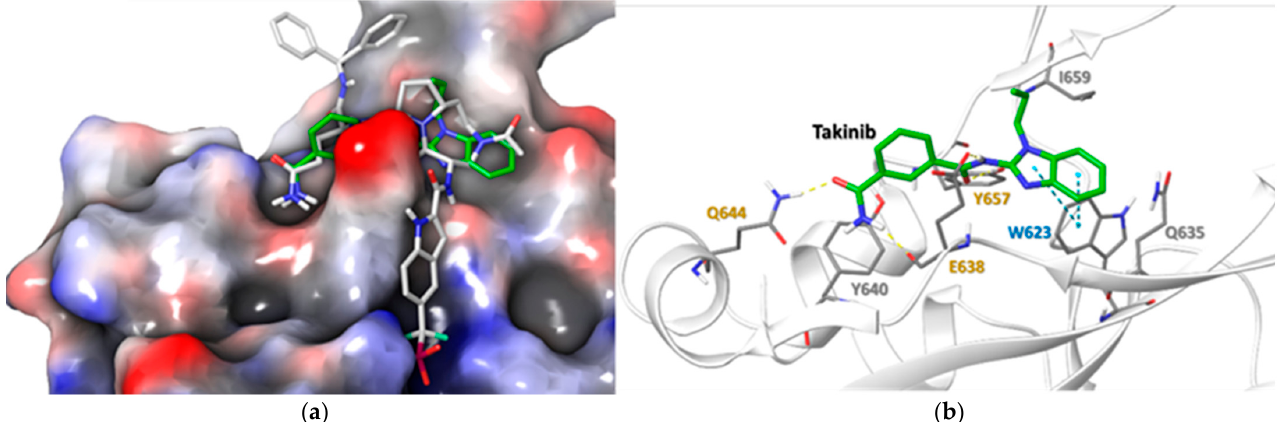
Figure 5. Docked pose of takinib in the binding site of STAT3 (PDB ID: 6NJS): ( a ) Showing electrostatic potential surface of the STAT3 with co-crystallized ligand (SD-36) and docked takinib. The red and blue color depict electronegative and electropositive surfaces while white color denotes hydrophobic surface. ( b ) The interaction of takinib with the binding site residues of STAT3. The light grey labelling represents the residues that leads to hydrophobic interaction with the ligand. The yellow and blue dotted line represent H-bonding and π - π interaction, respectively. The ligand in the active site is represented by thick stick model while interacting residues are represented in thin stick model. Table 1. Predicted takinib/STAT3 Binding Interactions and Known STAT3 Residue Function.